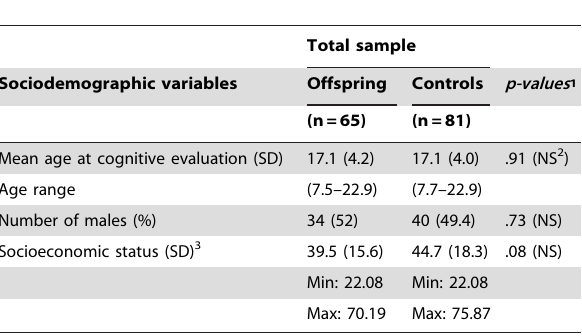
Table 1. Sociodemographic description of the